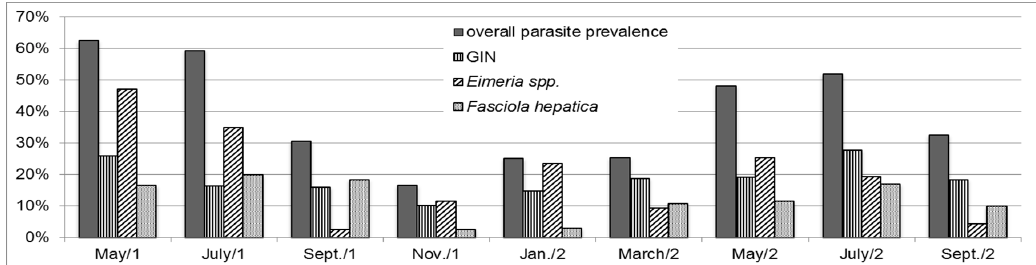
Figure 1. Occurrence of overall and most prevalent endoparasites in faecal samples of suckler calves, heifers and cows (in % of all samples, n = 708) in the course of 17 months from May in year one (May/1) to September in year two (September/2); GIN = gastrointestinal nematodes. Table 3. Occurrence (in %) of parasite species (in alphabetical order) in faecal samples ( n = 708) of the five sampled herds (A–E).